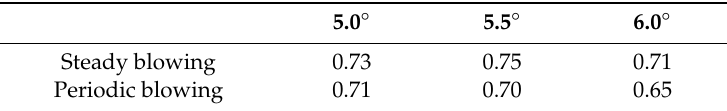
Table 2. Mean lift coe ffi cients with and without